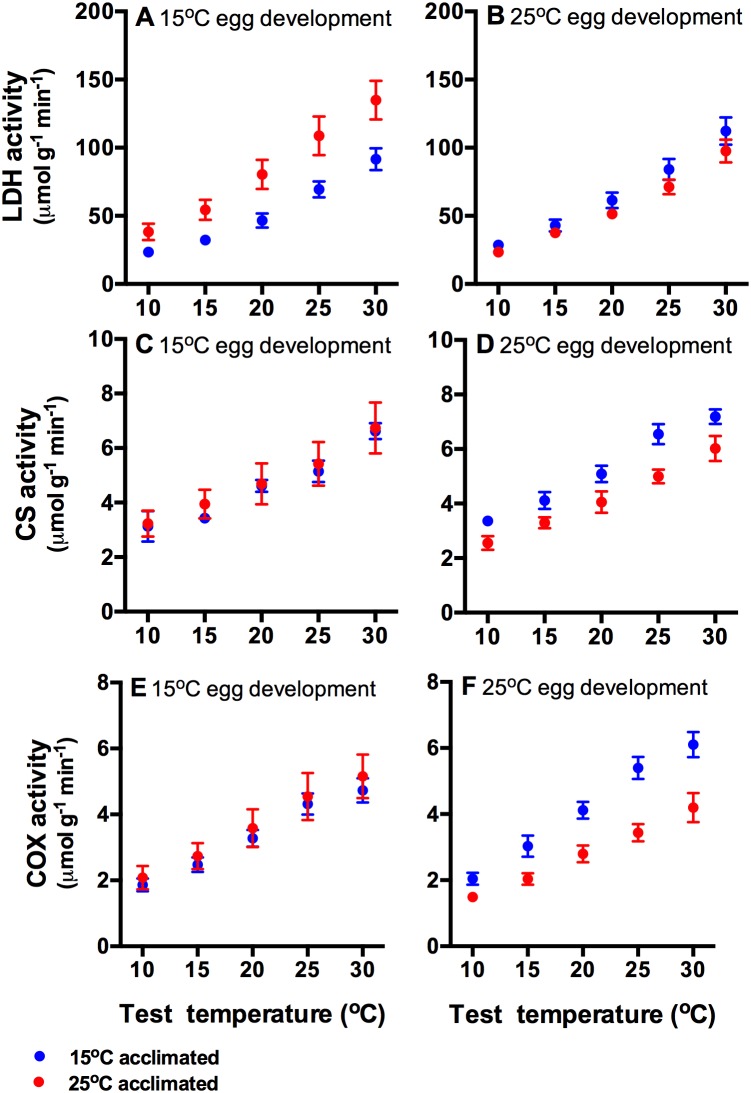
Activities of enzymes (mean ± s.e.) important for glycolytic (lactate dehydrogenase, LDH [A, B], and mitochondrial (citrate synthase, CS [C, D]; cytochrome c oxidase, COX [E, F]) energy (ATP) production.Data from eggs incubated at 15°C are shown in the left panels, and those from eggs incubated at 25°C are shown in the right panels. After hatching, tadpoles were acclimated to either 15°C (blues circles) or 25°C (red circles). Enzyme activities were determined by interactions between incubation and acclimation temperatures (see text for details). N = 9 tadpoles per treatment.